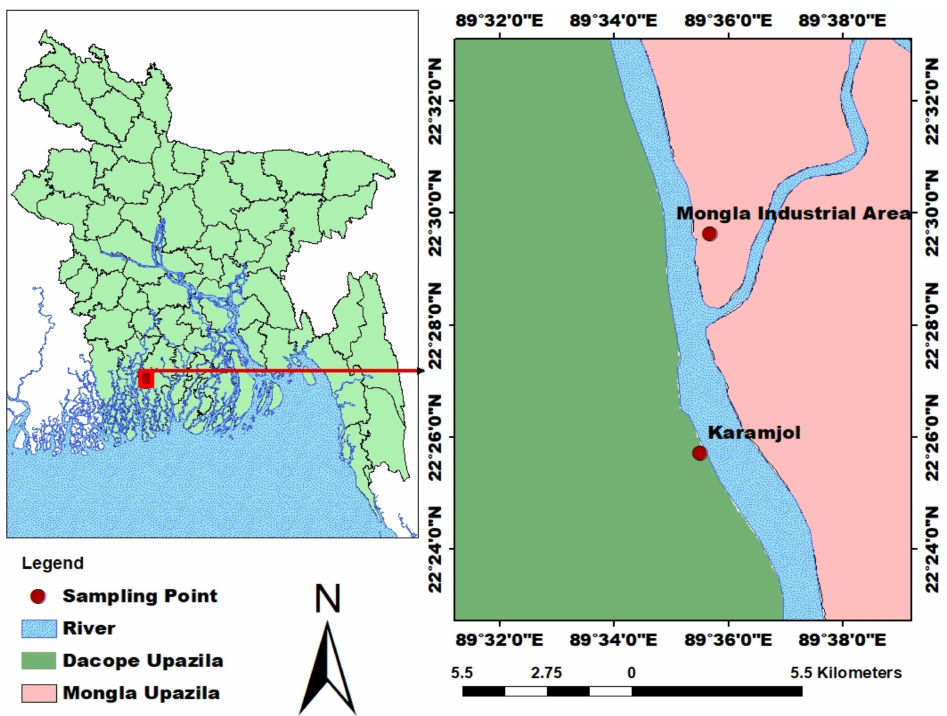
Figure 1. Map of the study area. Two sampling stations are shown in red